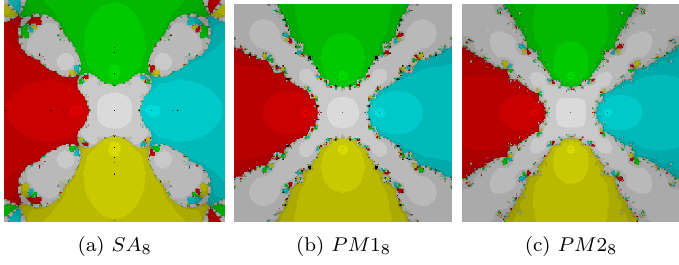
Figure 6. The methods for test problem